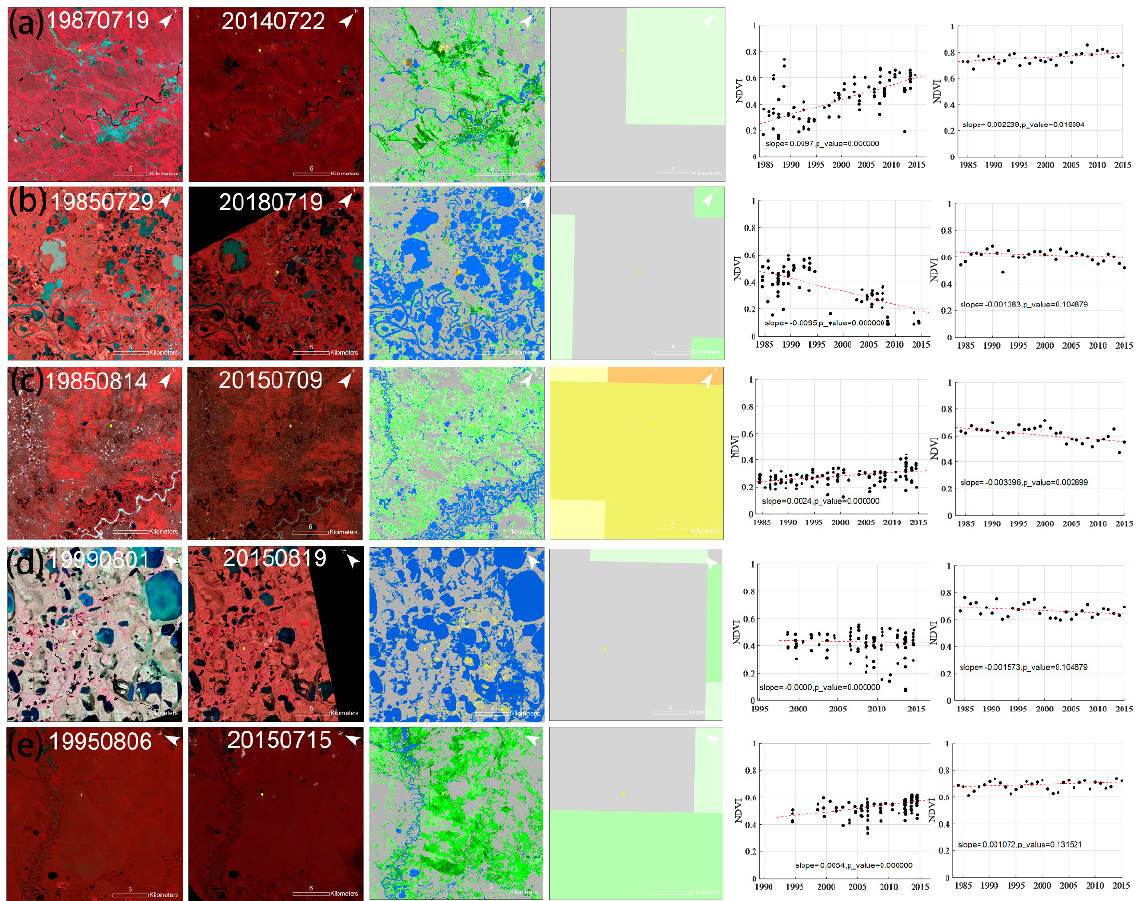
Figure 9. Each row shows a 20 km × 20 km site. From left to right: a 30 m Landsat false color image in an earlier year, a 30 m Landsat false color image in a recent year, a 30 m Landsat-based trend image, an AVHRR-based trend image, a Landsat NDVI time series (1984–2015) and an AVHRR NDVI time series (1984–2015) at the labeled pixel marked in Figures 4 and 8, respectively. ( a ) Greening shrub tundra, centered at 67.544 ◦ N, 63.744 ◦ E, in the northeastern Komi Republic. ( b ) Browning trend due to natural resource development, centered at 70.417 ◦ N, 68.265 ◦ E, in the northern Yamal Peninsula. ( c ) Slightly greening graminoid tundra, centered at 72.582 ◦ N, 70.050 ◦ E, in the northern Yamal Peninsula. ( d ) Stable tussock sedge tundra, centered at 70.482 ◦ N, 145.857 ◦ E, in the northern Sakha Republic. ( e ) Greening tussock sedge tundra, centered at 69.141 ◦ N, 171.830 ◦ E, in northern Chukotka. The color code of the trend values is the same as in Figures 4 and 8,